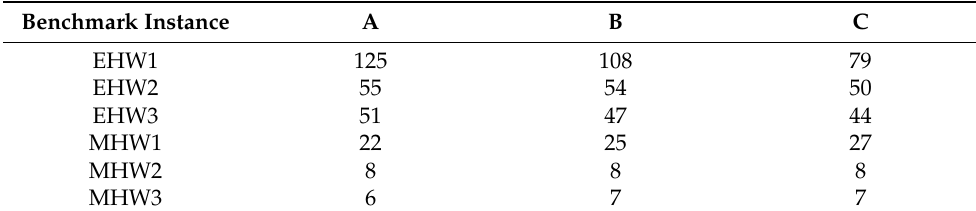
Figure 7. Values of selected parameters—evolutionary method. Table 15. Average optimization time (in seconds).